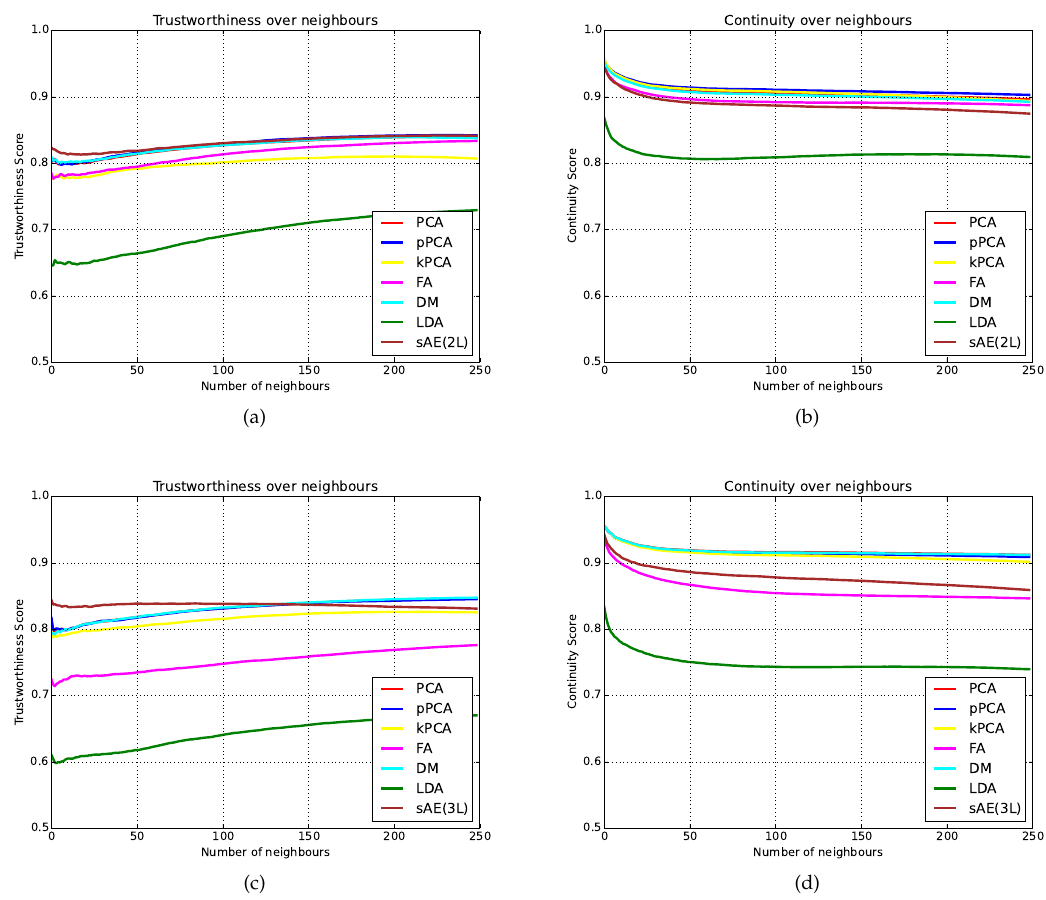
Figure 5. Trustworthiness and continuity plots across the different dimensionality reduction techniques for number of neighbors ( 1 : 250 ) . ( a ) Trustworthiness; ( b ) Continuity; ( c ) Trustworthiness (Weighted Parameters); ( d ) Continuity (Weighted